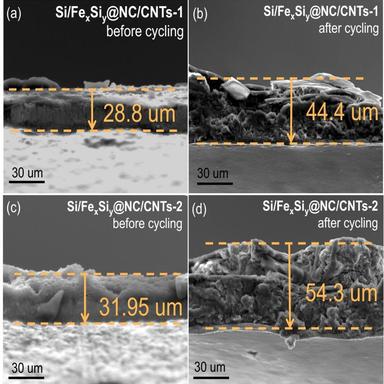
The cross-sectional images of (a, b) Si/FexSiy@NC/CNTs-1 and (c, d) Si/FexSiy@NC/CNTs-2 before cycling and after cycling.